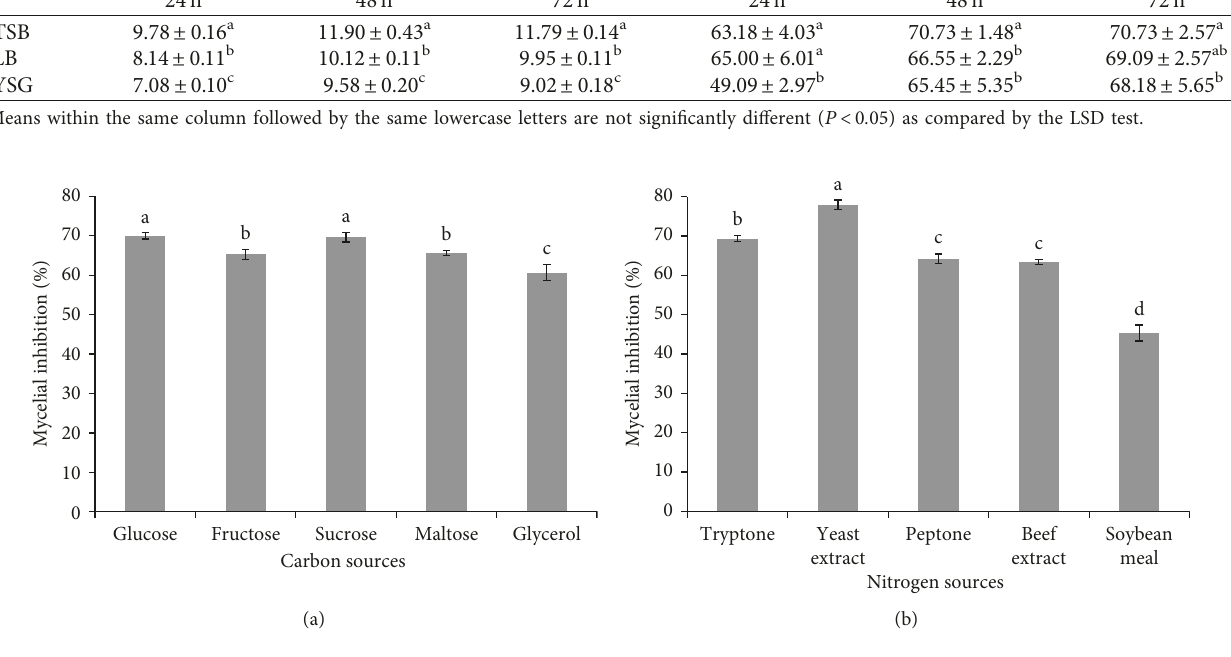
Figure 1: Effect of various carbon (a) and nitrogen (b) sources in the TSB medium on antifungal activity of X. stockiae